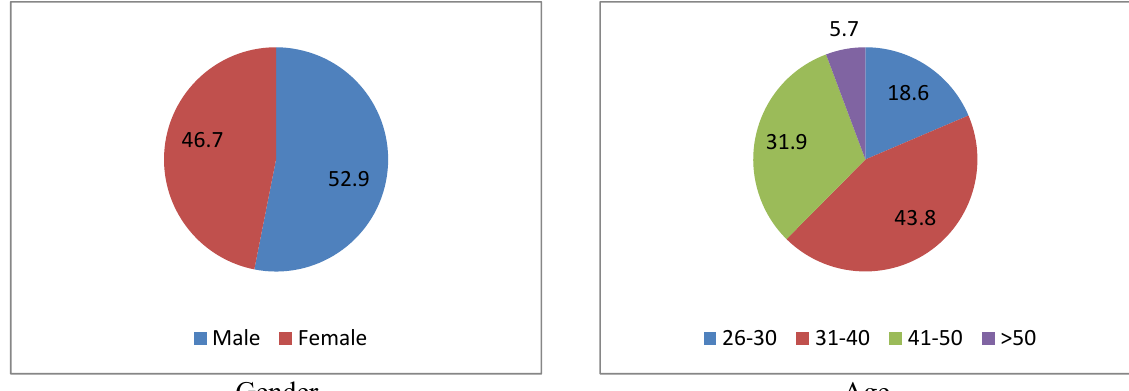
Fig. 2. Personal characteristics of the participants